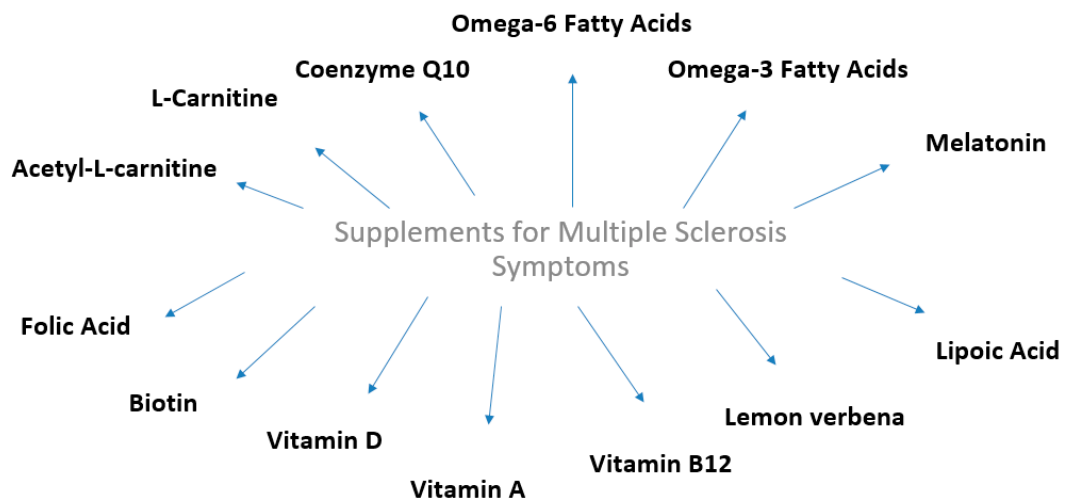
Figure 1. Dietary supplements that exert beneficial e ff ects against multiple sclerosis symptoms and relapses.